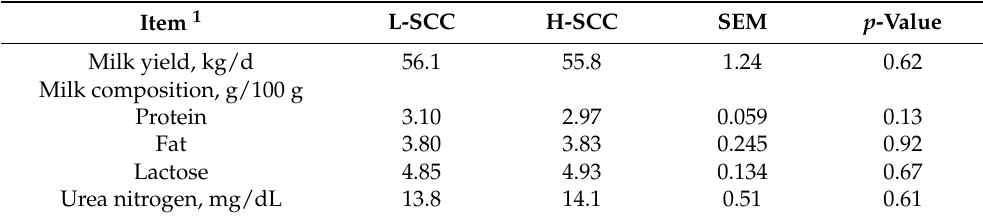
Table 1. Lactation performance of high-yielding dairy cows with different somatic cell count (SCC). Item 1 L-SCC H-SCC SEM p -Value Milk yield,